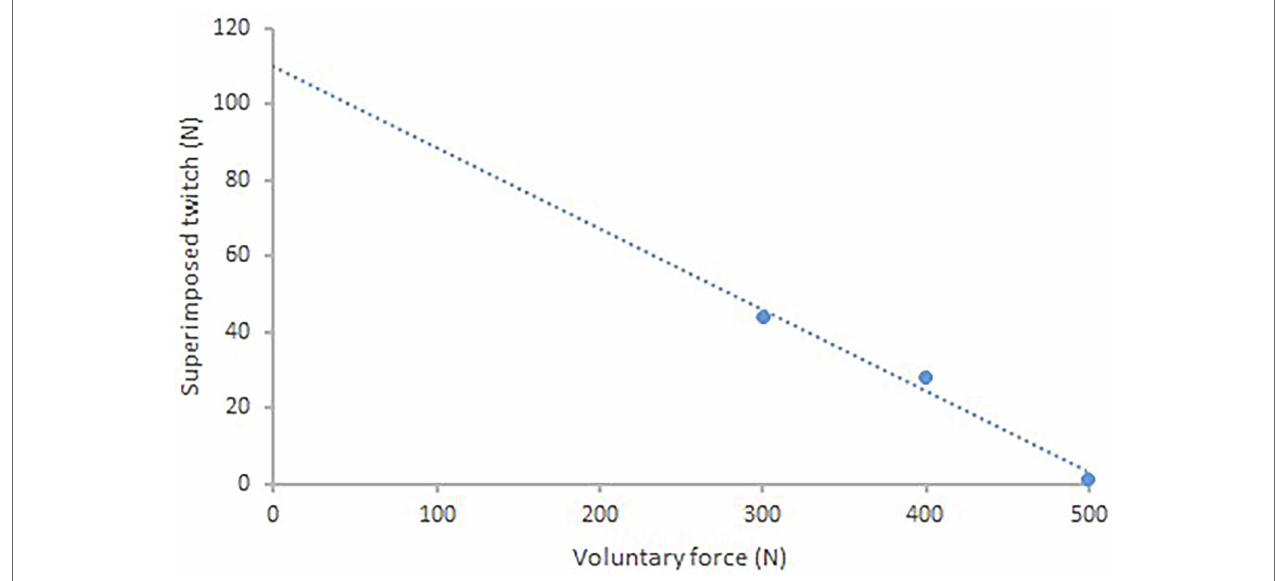
FIGURE 2 | Single subject data showing linear regression between the amplitude of the TMS superimposed twitch and voluntary force ( r = 0.99). The y -intercept (114.5 N) is taken as the estimated amplitude of the resting twitch.